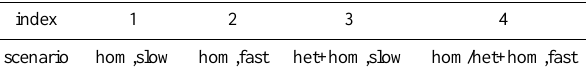
Table 2. Numbering for the different pdfs of scenarios as fol- lows: hom,slow : pure homogeneous nucleation for slow vertical updraughts, hom,fast : pure homogeneous nucleation for faster ver- tical updraughts, het+hom,slow : heterogeneous+homogeneous nu- cleation for slow vertical updraughts, hom/het+hom,fast : pure ho- mogeneous and heterogeneous+homogeneous nucleation for fast vertical updraughts.